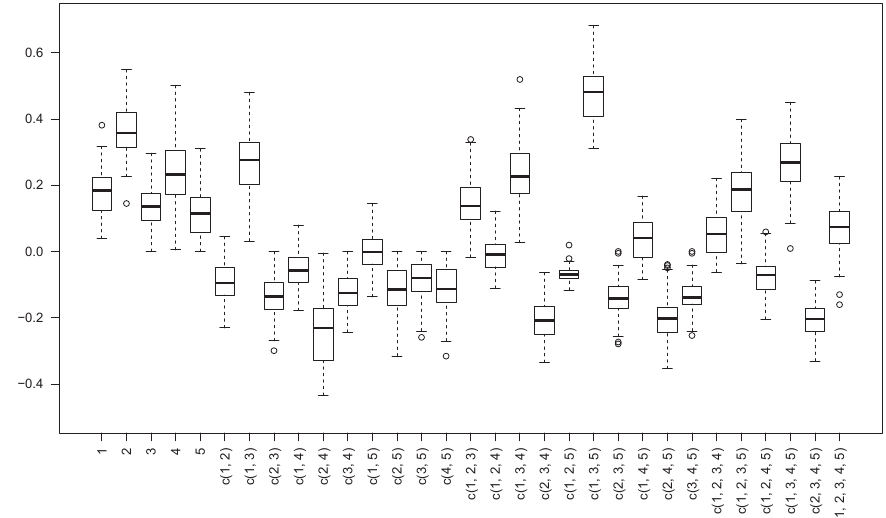
Figure 2. The nonadditivity index matrix N 2 by Algorithm 3.